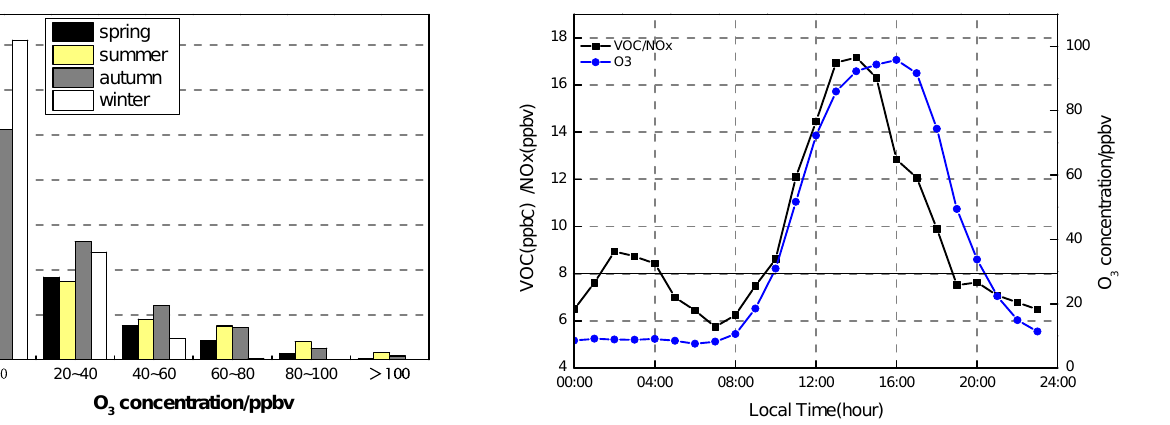
Figure 9. The variation patterns of VOC / NO x ratio and ozone con- centration at a high ozone episode at GPACS. High ozone episode refers to the day with an hourly ozone value higher than 93ppbv. A black level line represents the VOC / NO x of 8 :